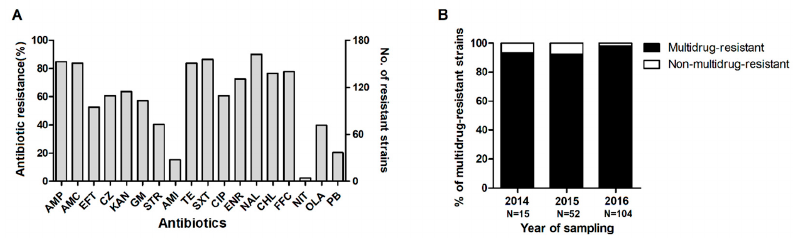
Figure 4. Resistance of the E. coli isolates from piglets with diarrhea to various antimicrobial agents. ( A ) The frequency of antibiotic resistance and the number of resistant strains among intestinal pathogenic E. coli from Chinese large-scale swine farms. ( B ) Proportion of multidrug-resistant strains between 2014 and 2016. The results of the tests for ampicillin (AMP), amoxicillin–clavulanate (AMC), ceftiofur (EFT), cefazolin (CZ), kanamycin (KAN), gentamicin (GM), streptomycin (STR), amikacin (AMI), tetracycline (TE), trimethoprim–sulfamethoxazole (SXT), ciprofloxacin (CIP), enrofloxacin (ENR), nalidixic acid (NAL), chloramphenicol (CHL), florfenicol (FFC), nitrofurantoin (NIT), olaquindox (OLA), and polymyxin B (PB) were interpreted according to CLSIM100-S26 and CLSI VET01-A4 guidelines. Multidrug-resistant isolates were those resistant to three or more antimicrobial classes, and intermediate isolates were not